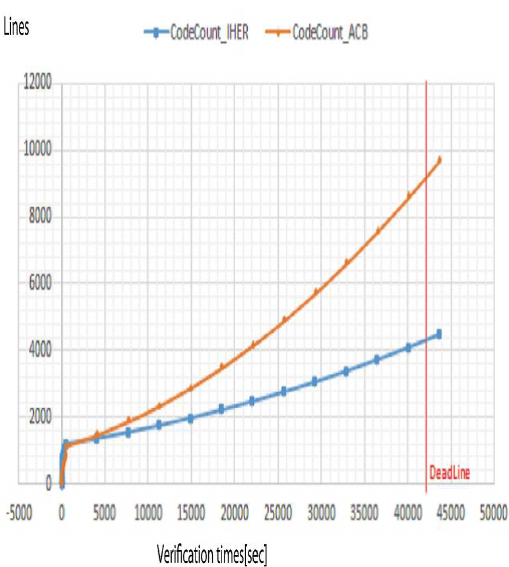
Figure 13. Verification lines of program 2 for verification